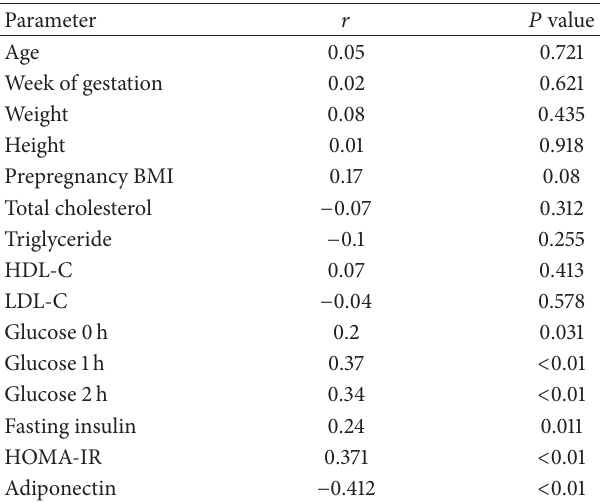
Table 2: Univariate correlations with serum pigment epithelium- derived factor (PEDF) levels in gestational diabetes mellitus (GDM) patients.